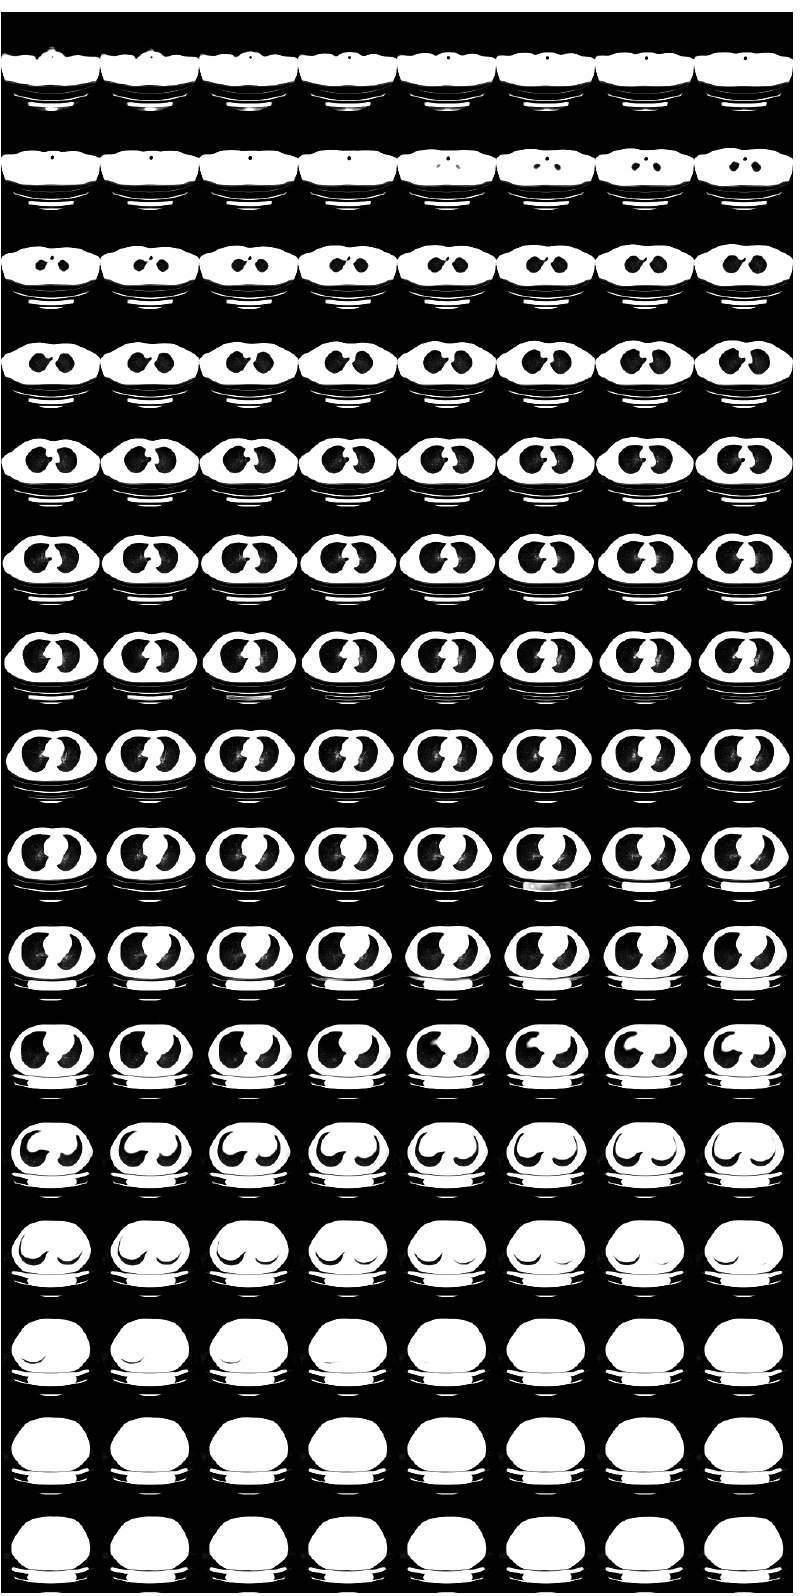
Figure 8. Reconstructed 3D CT image with X2CT-FLOW from Figures 7c,d ( σ 2 = 100, N = 2), in a pulmonary window